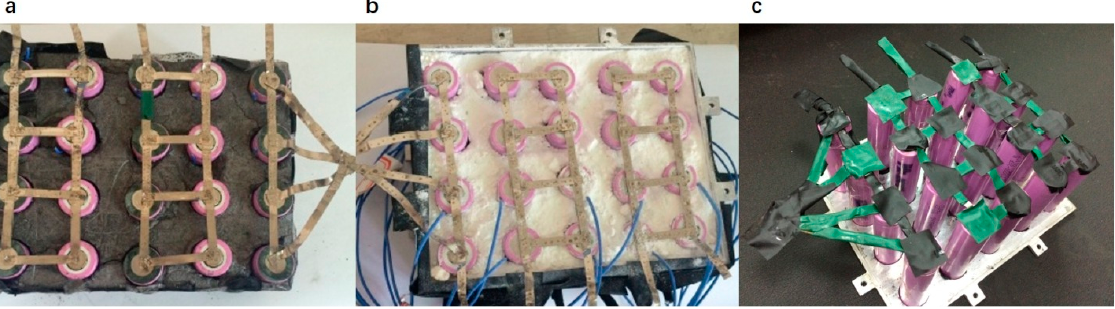
Figure 2. Li-ion battery packs: ( a )—60 wt% RT44HC/EG; ( b )—60 wt% RT44HC/fumed silica; ( c )—no PCM. Reproduced from [34] with permission from Elsevier.